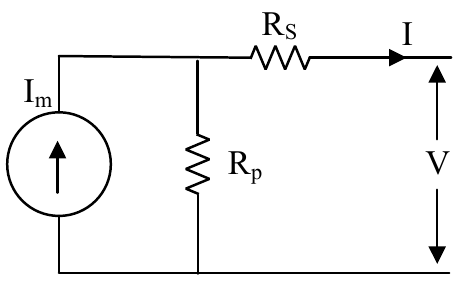
Figure 3. A simplified PV Model.